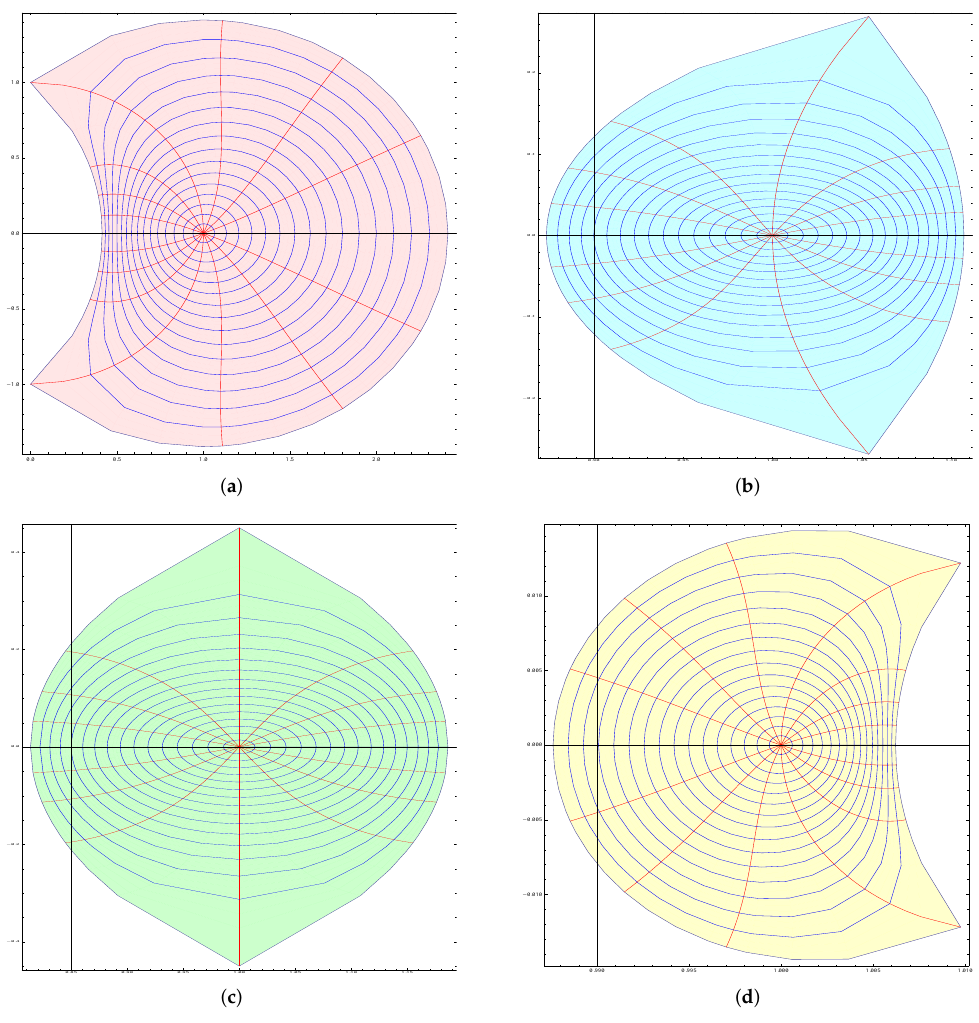
√ 1 + z 2 . ( a ) Mapping √ 1 + z 2 . ( b ) Mapping of E under the